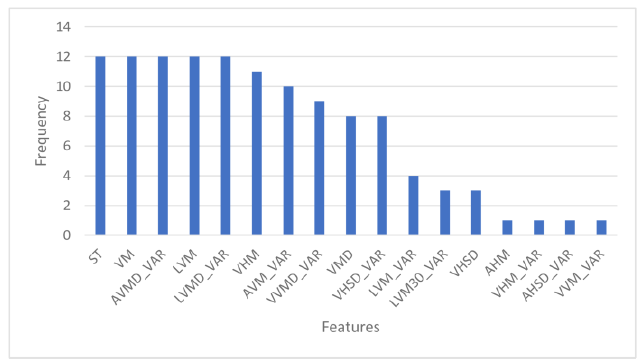
Figure 10. Frequency of features selected by MRMR.